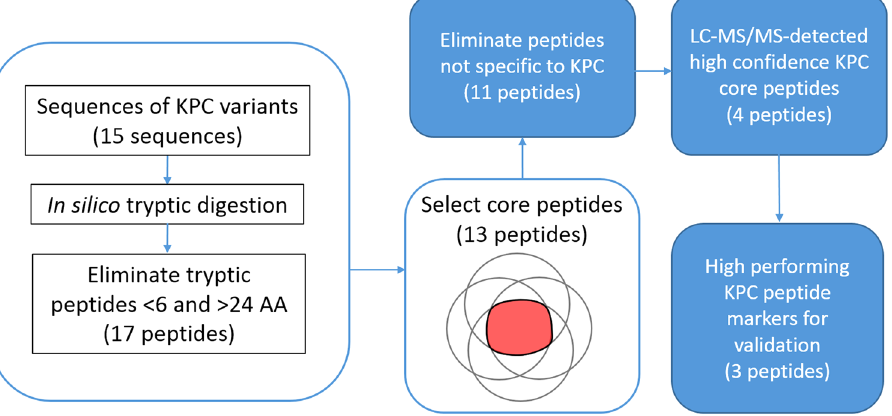
Figure 1. Genoproteomic approach to identify and detect high performing core peptides specific to the KPC protein. A multiple sequence alignment of 15 KPC variants was subjected to in silico tryptic digestion. Peptides < 6 and > 24 amino acids in length were eliminated, and a set of core peptides common to at least 14 KPC variants was selected. Analysis with BLASTP and LCA were used to eliminate peptides not specific to KPC. High performing peptides were selected for validation from the set of high confidence core peptides that could be detected by LC-MS/MS. The numbers of peptides in parentheses are the numbers remaining after each selection